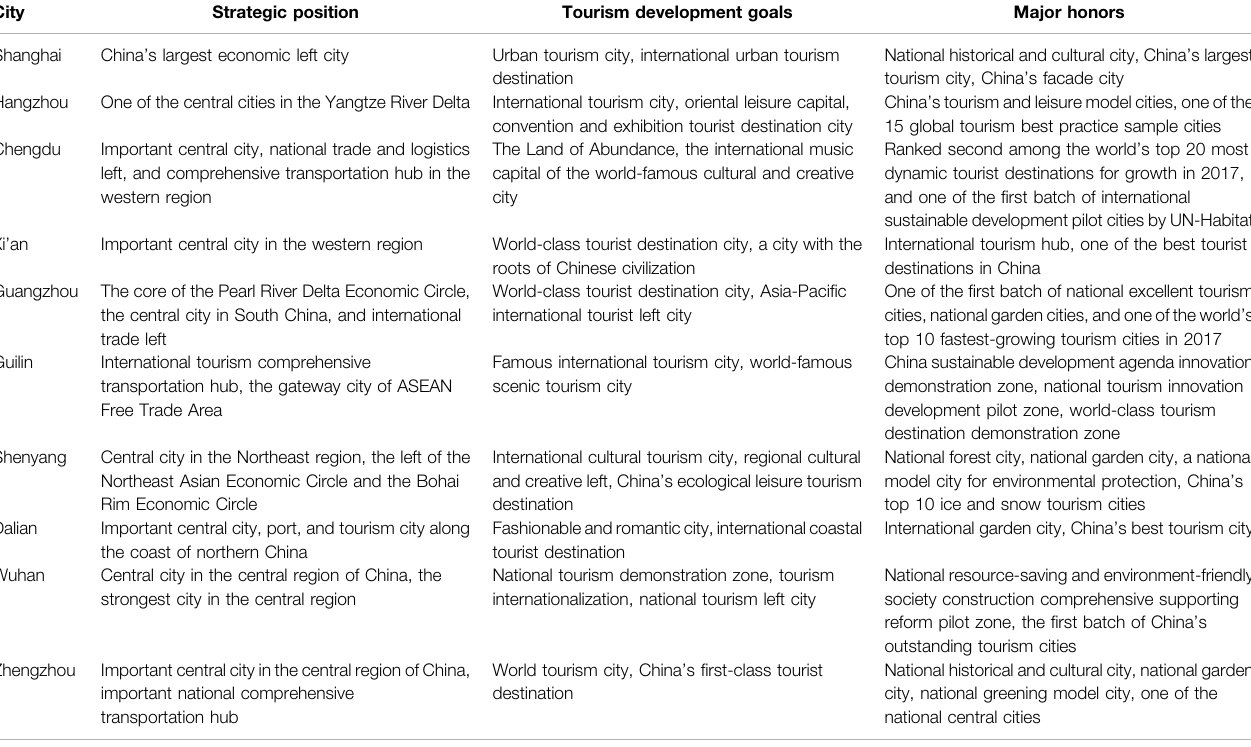
TABLE 7 | Brief introduction of low-carbon tourism cities.